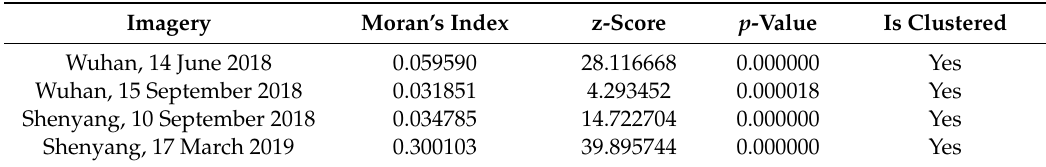
Table 3. The Global Moran’s I